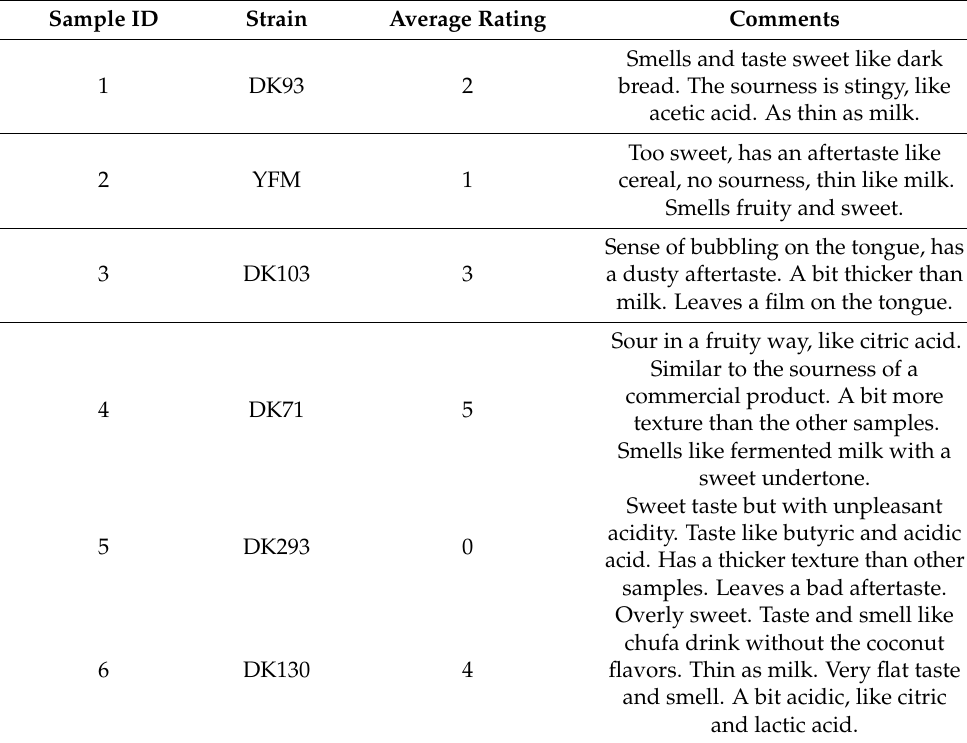
Table 5. Results of the sensory analysis. The average rating was ranked from least liked (0) to most liked